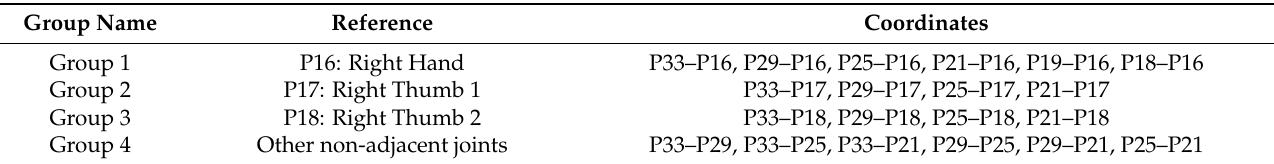
Table 2. Differences of R_Z between non-adjacent